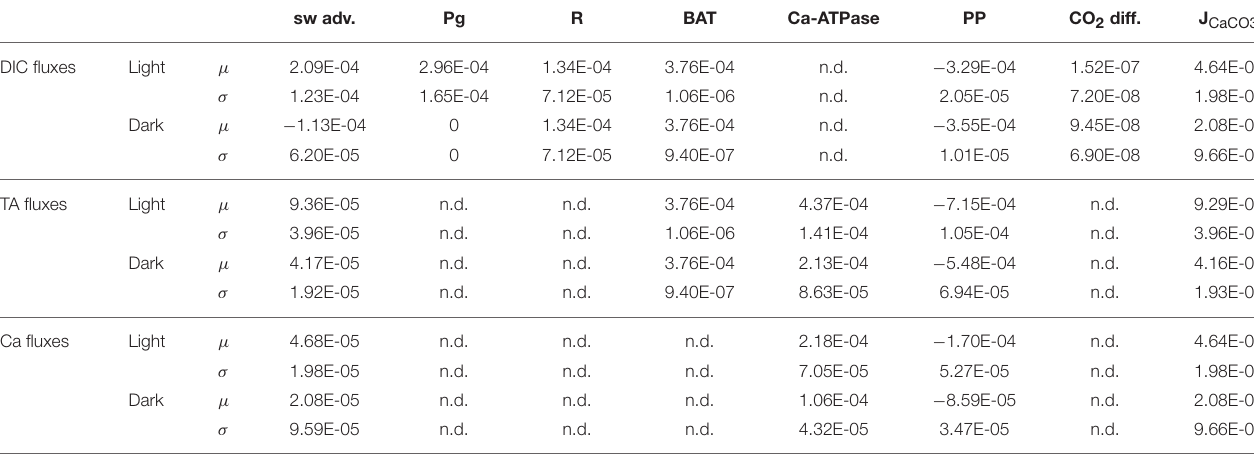
TABLE 4 | Mean ( µ ) and standard deviation ( σ ) of DIC, TA, and Ca 2 + fluxes ( µ mol cm − 2 s − 1 ). sw adv. BAT